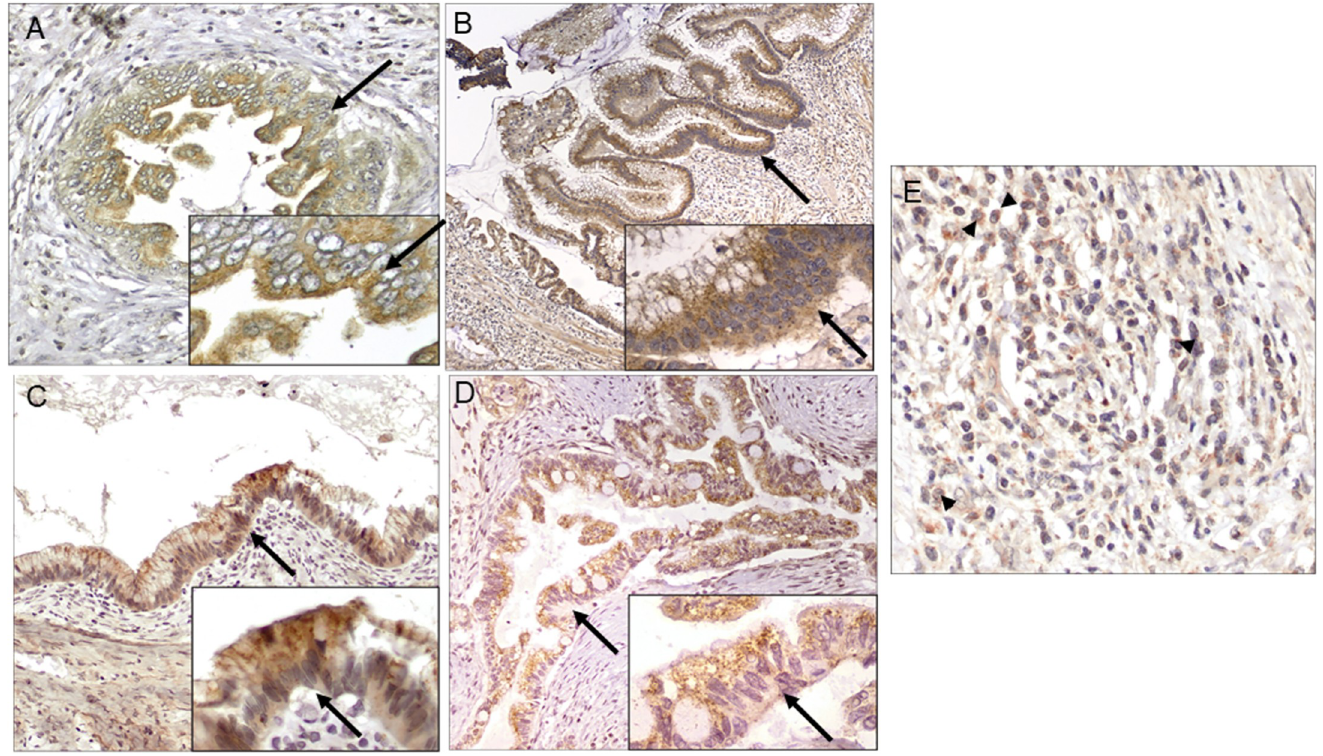
Fig 3. RNLS distribution in human precursor and PDAC tissue. Representative images of RNLS labeling detected by immunohistochemistry using the m28-RNLS antibody in: (A) PanIN, (B) IPMN, (C) MCN, and (D-E) PDAC. Intense granular cytoplasmic staining is present in the majority neoplastic epithelial cells, and in a subset of mononuclear inflammation near tumor. The black arrows point to ductal cells in (A) PanIN, (B) IPMN, (C) MCN, and (D) PDAC. The black arrowheads point to mononuclear inflammatory cells in the PDAC stroma. Original magnification: A, E 400x, inset 600x; B 100x, inset 600x; C, D 200x, insets 400x.